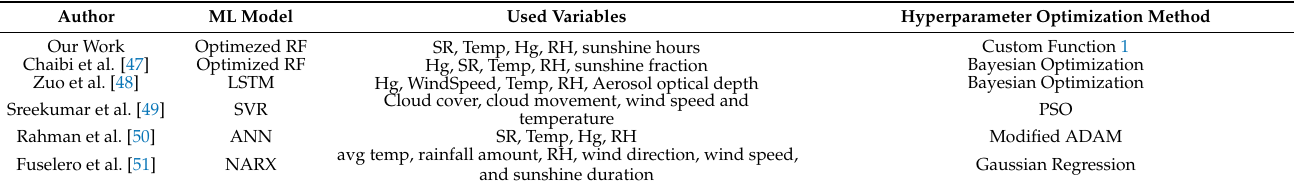
Table 7. Comparison of similar works involving solar radiation